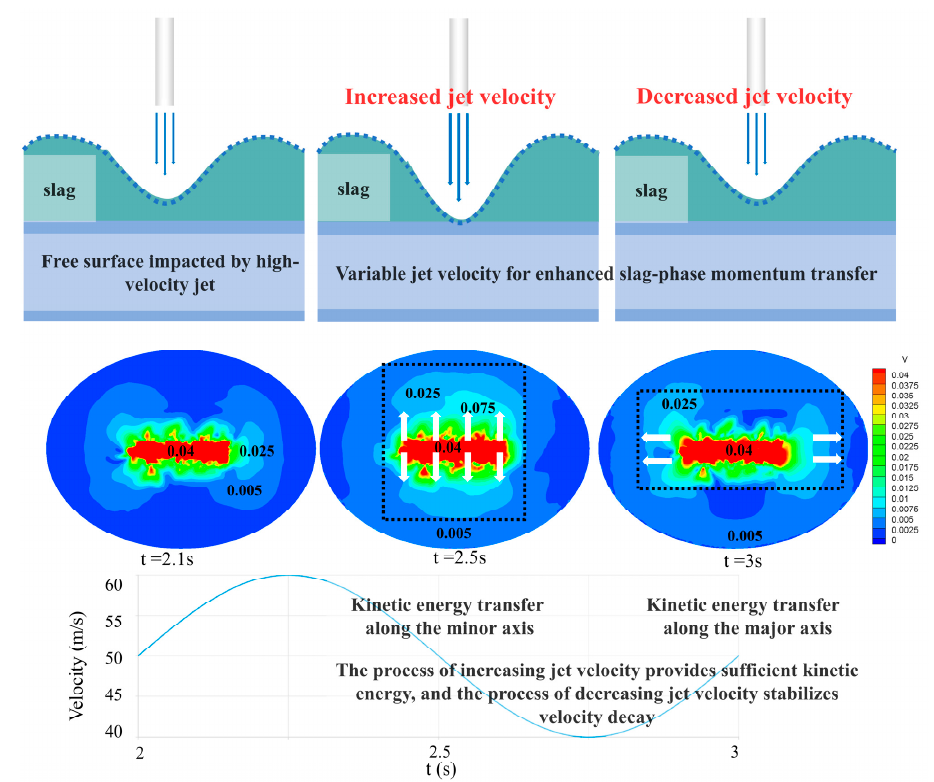
Figure 18. SWB enhanced mixing mechanism.